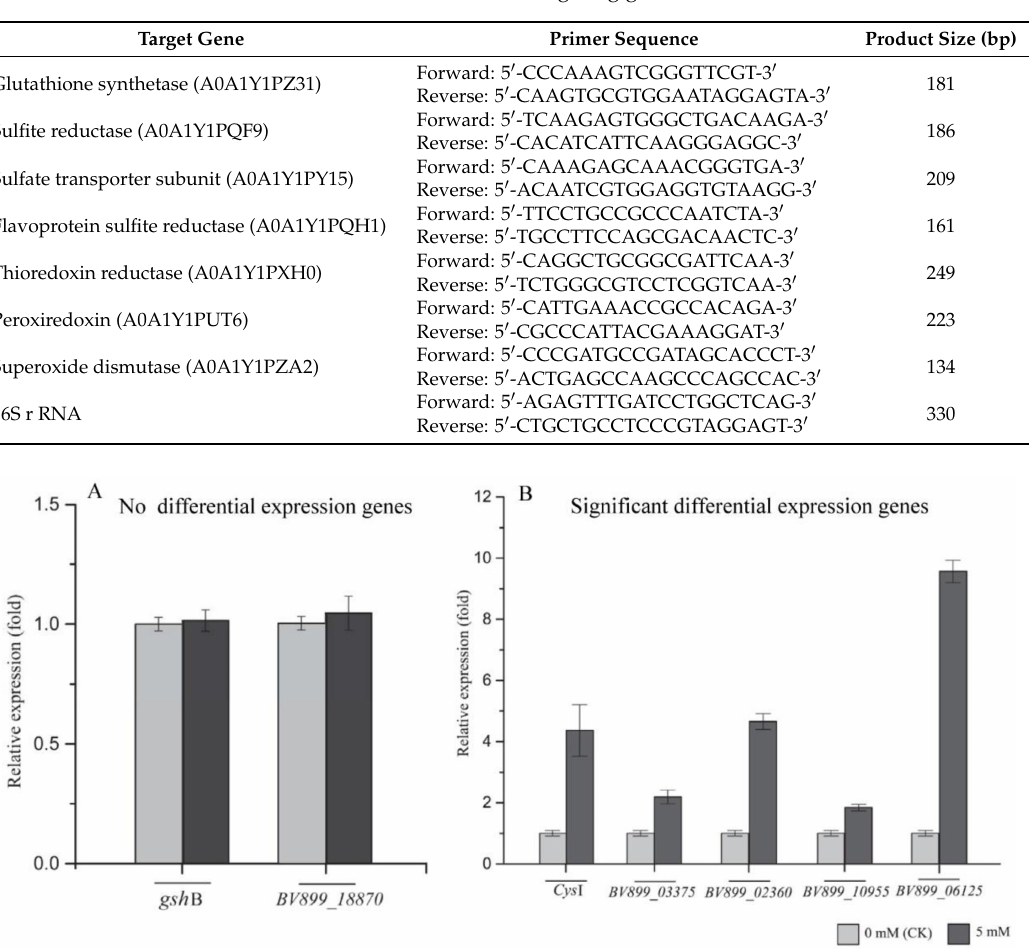
Table 2. Primers for targeting genes.